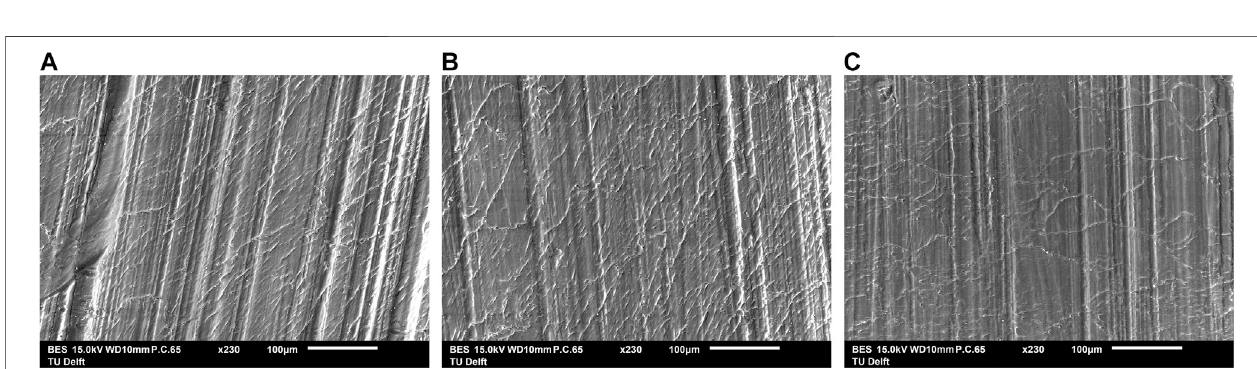
FIGURE9| SEMimagesofthesurfaceofPSU: (A) unaged, (B) exposedtoO 2 5 bar 120 ° Cfor8 weeksand (C) exposedto30 wt%KOHat90 ° Cfor61 days.The images look very much alike.